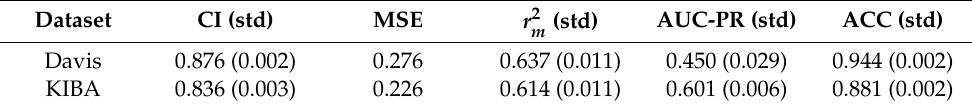
Table 3. Detailed evaluation metric scores for each fold in the 5-fold cross validation. Dataset